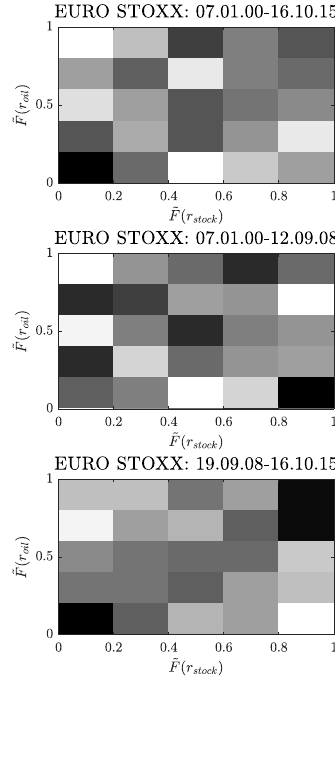
Figure 2: Empirical joint distribution for returns of EUROSTOXX and Brent oil denominated in Euros. Top figure shows the empirical joint distribution function for all the sample, middle graphs represents the pre-crisis subsample and the bottom one the post-crisis subsample. Darker colours indicate a higher data clustering on certain part of the distribu- tion. Looking at the entire sample and assessing a constant copula parameter may overlook the complex dependence evolution within the